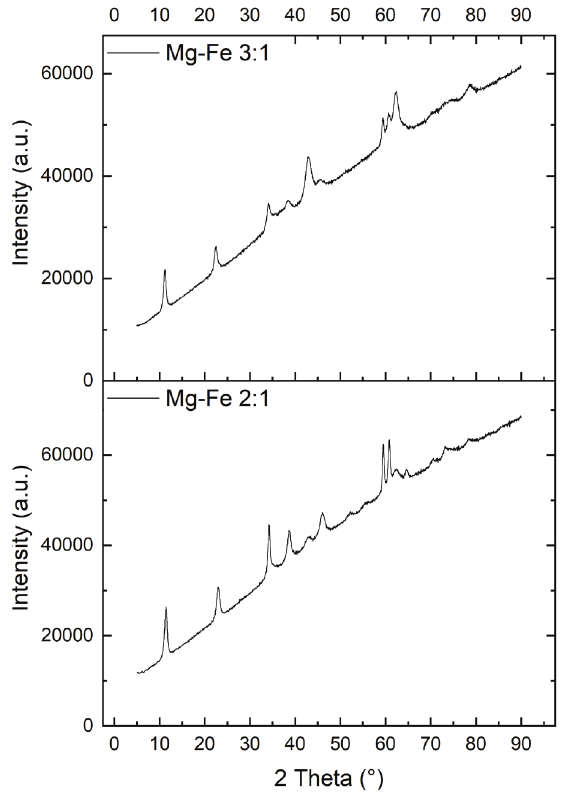
Fig. 2 – X-ray diffractogram of prepared Mg-Fe